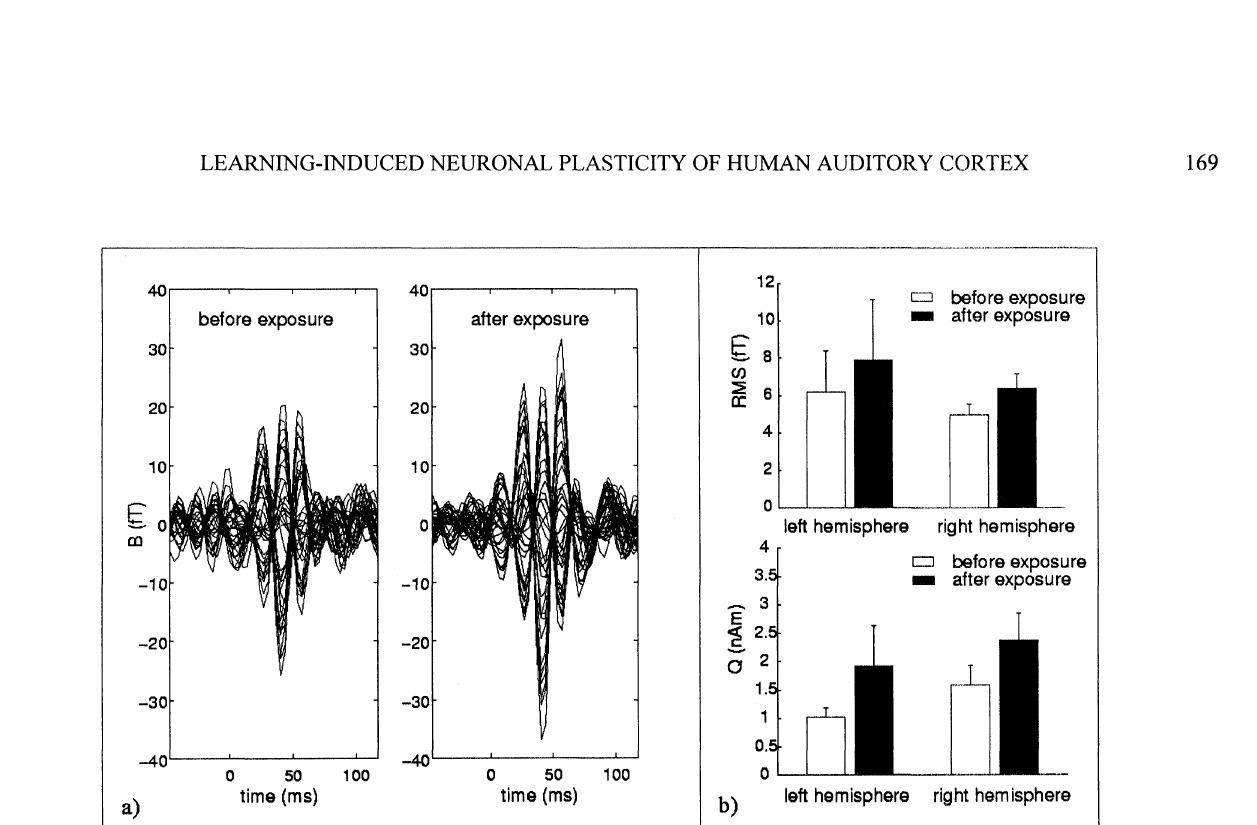
Fig. 3: (a) Gamma-band responses of one subject to the complex tone of the sequence (band pass filtering: 24- 48Hz). Data of the 37 measurement channels are plotted together for the session before (left) and the session after week exposure (right). b) RMS values(top) and dipole moments of evoked gamma-band activity for the left and the right hemisphere, cross-averaged over all subjects. Black bars show the values after, and white bars before exposure. Error bars indicate the s.e.m.